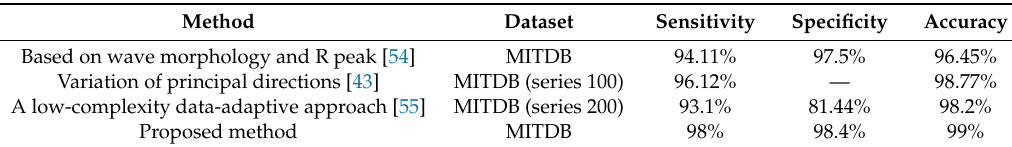
Table 12. Performance of some other published methods for PVC